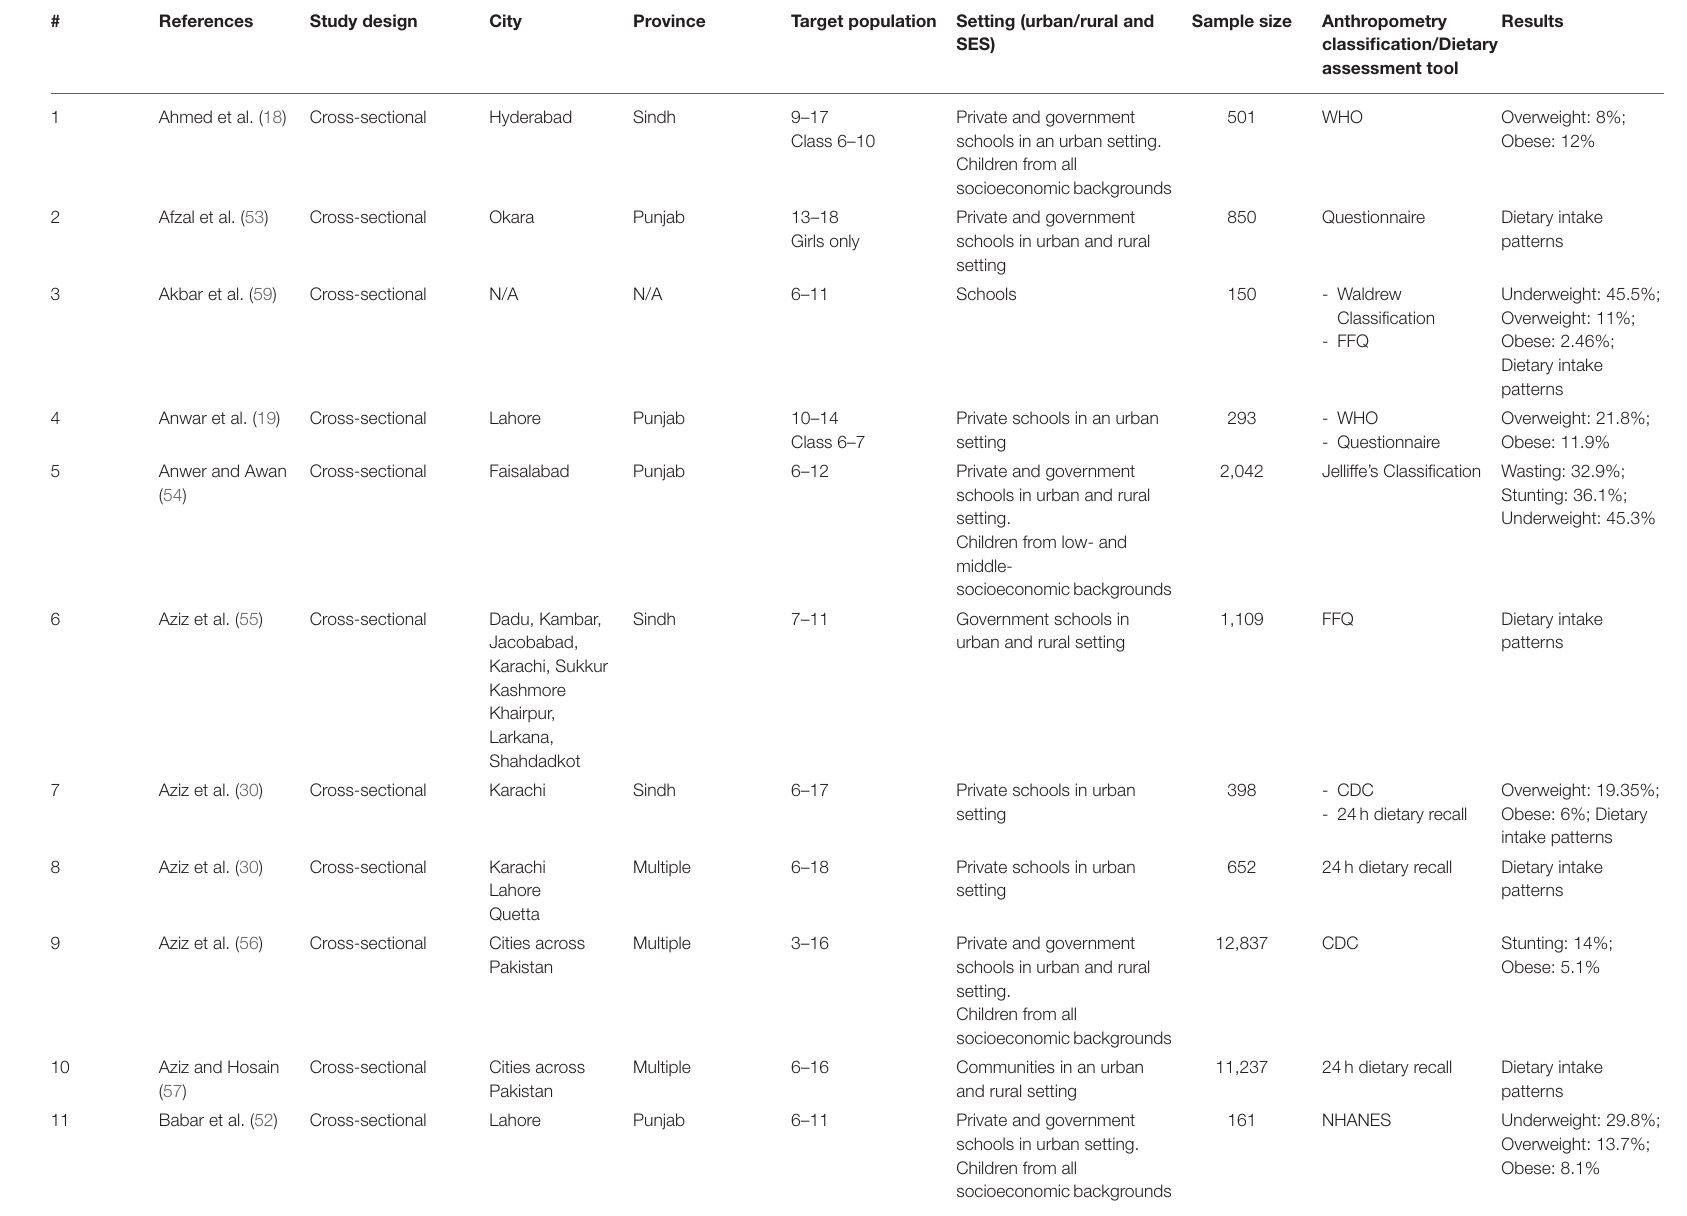
TABLE 1 | Brief overview of characteristics of included